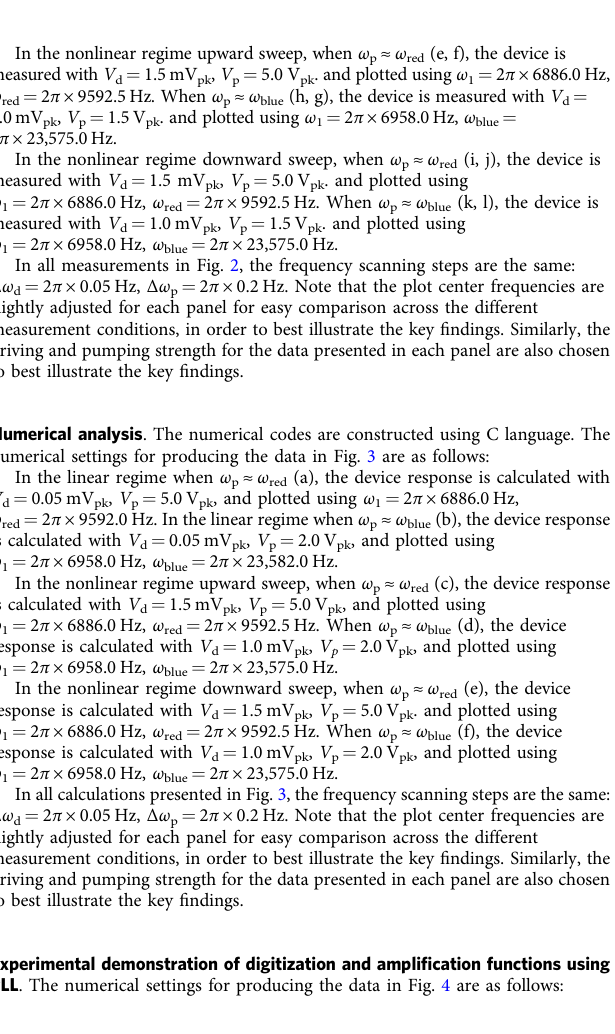
Fig. 5 Experimental demonstration of signal transduction and ampli fi cation using the nonlinear phonon-cavity system at the blue pump. a The frequency response curves as functions of ω 2 in downward frequency sweep measurements. b Fast measurement of ω b as functions of ω 2 . The white circles are the PLL measured data, and the solid colors on both sides offer visual cues to the eye. c The output shift in ω b as functions of ω 2 in the digitization region measured by PLL. d The output ω b as functions of ω 2 in the ampli fi cation region measured by